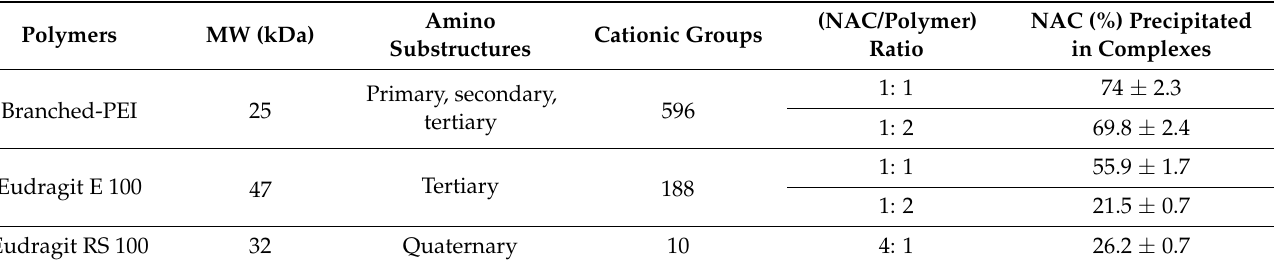
Table 2. N -acetylcysteine (NAC) precipitation percentages found in ionic complexes with different selected